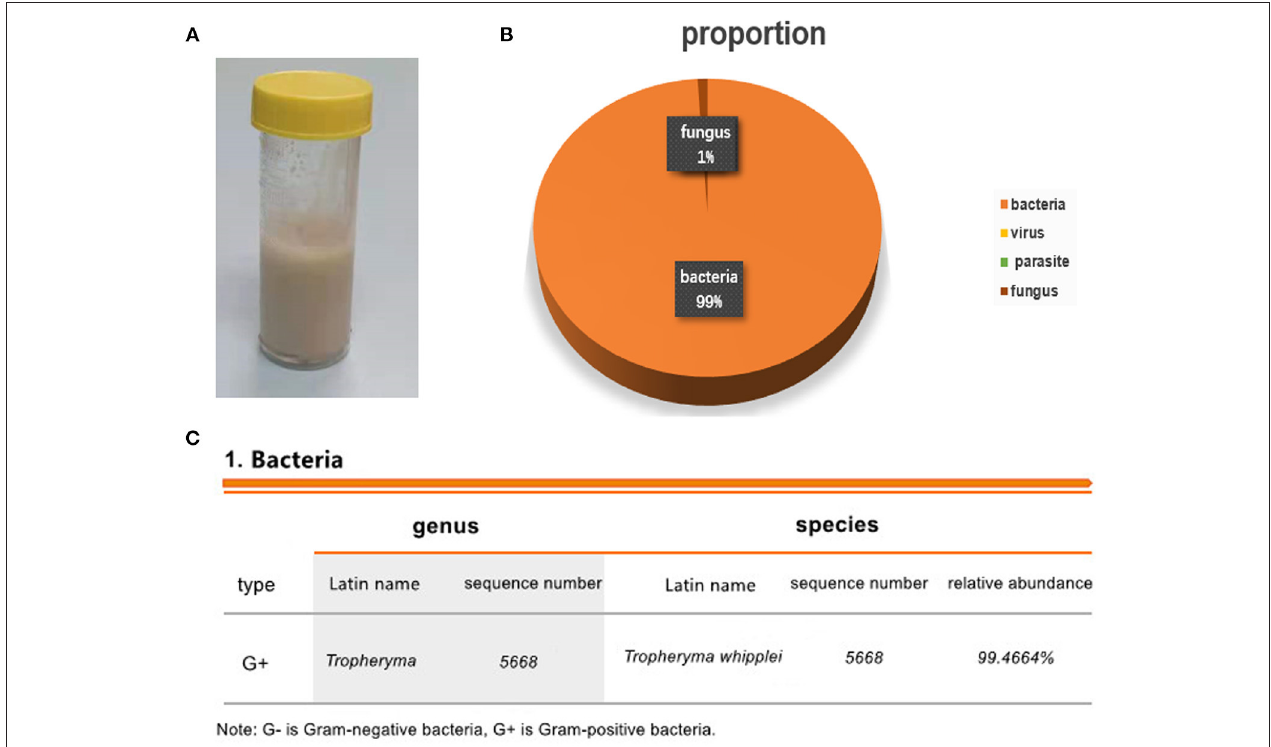
FIGURE 2 | Results of the next-generation sequencing of bronchoalveolar lavage fluid. (A) Bronchoalveolar lavage fluid. (B) The results showed that the relative abundance of Tropheryma whipplei was 99.4664%. The number of sequences was 5668. (C) The proportions of bacteria, viruses, parasites and fungi.